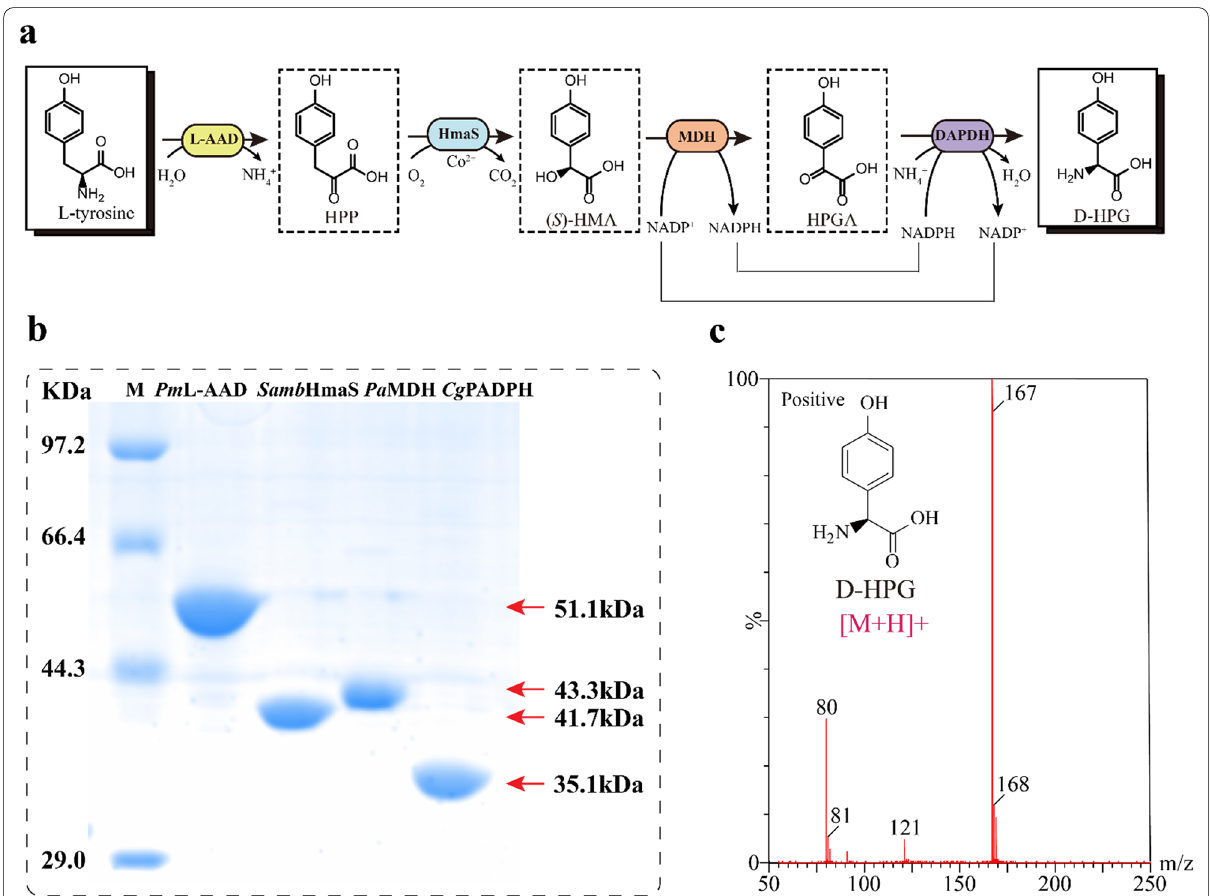
Fig. 2 Cascade design and in vitro reconstruction of D-HPG biosynthesis pathway. a Schematic representation of D-HPG biosynthesis from L-tyrosine through a four-enzyme cascade. b Cascade pathway protein characterization. c Analysis of the in vitro reconstructed system with LC– MS. The four-enzyme system was supplemented with 10-mM L-tyrosine, 0.5-mM NADP + , 20-mM NH 4 Cl, and 0.5-mM CoSO 4 , and each of the four purified enzymes with 10